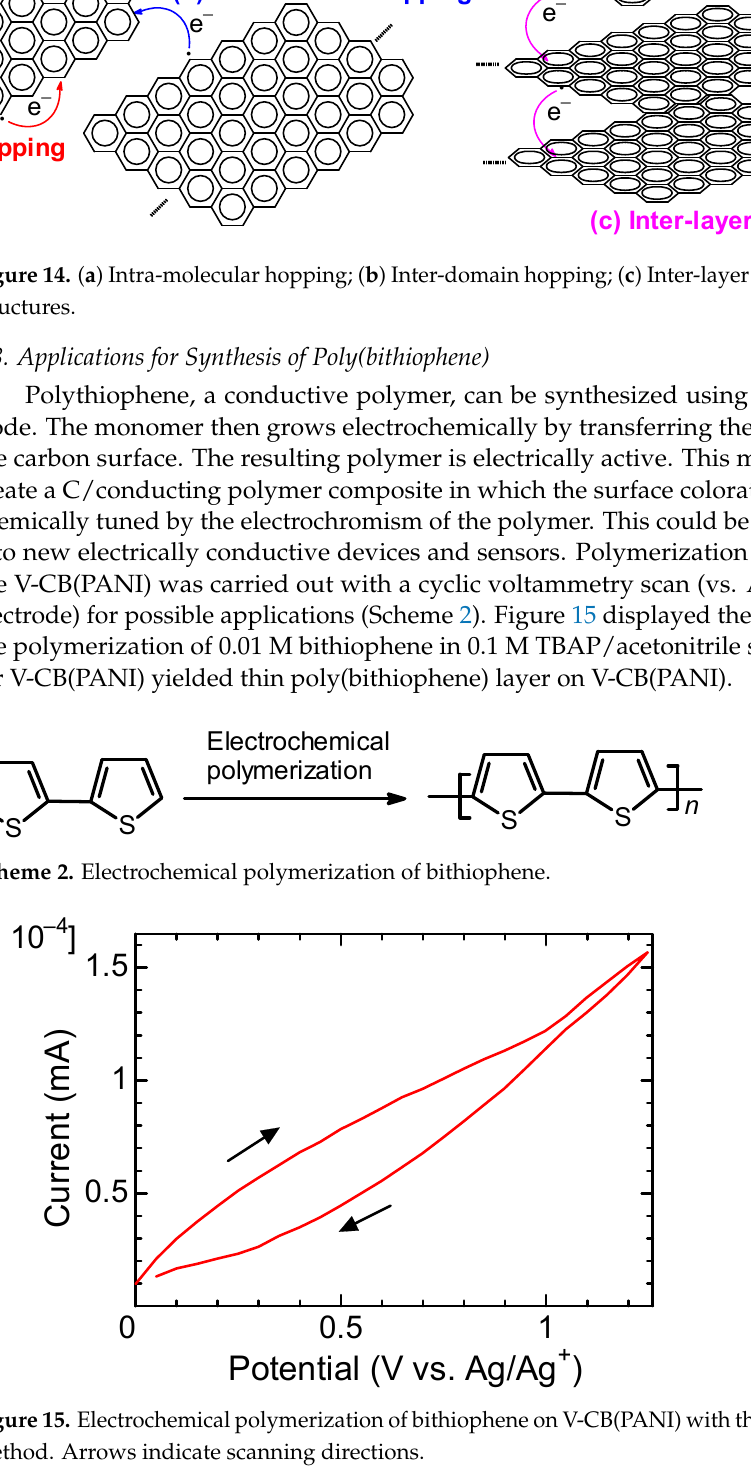
Figure 13. 1/ R ( ∝ σ ) as a function of temperature, replotted from Figure 12a.